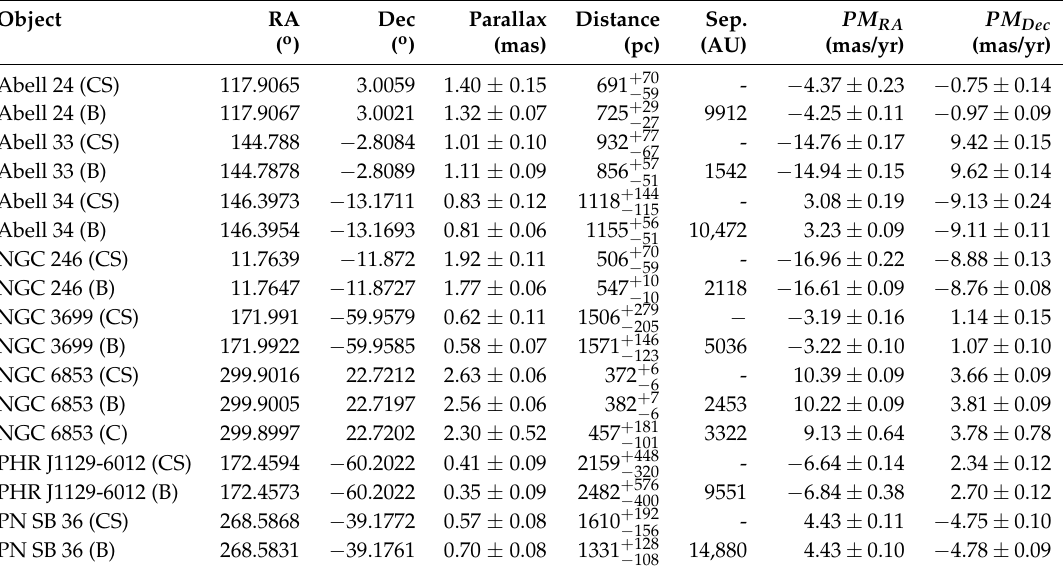
Table 1. Astrometric data of the central and companion stars of each